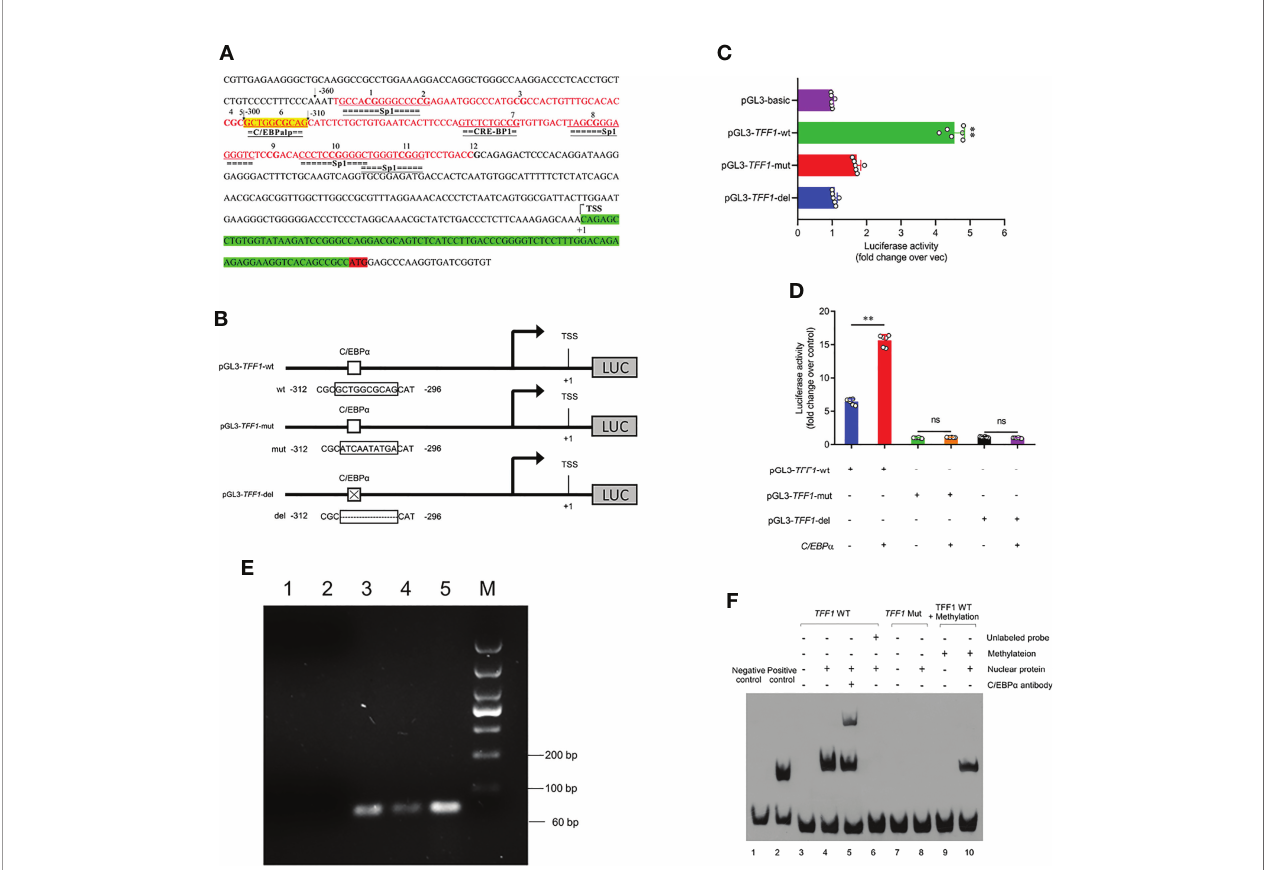
FIGURE 5 | C/EBP a activates the TFF1 expression. (A) Schematic representation of the TFF1 promoter sequences. C/EBP a potential binding site is highlighted in yellow. CpG island is highlighted in red and CG sites are shown in bold font. TSS was the transcription start site, and de fi ned as +1. (B, D) The pGL3- TFF1 recombinant vectors (with or without C/EBP a consensus site) were constructed and co-transfected with C/EBP a -oe into IPEC-J2. (C) The pGL3- TFF1 constructs (pGL3- TFF1 -wt, pGL3- TFF1 -mut and pGL3- TFF1 -del) were transfected into IPEC-J2. Luciferase reporter assays were performed 36 hours post transfection. (E) Identi fi cation of C/EBP a binding to TFF1 promoter by ChIP-PCR. Lane 1, PCR ampli fi cation with RNase-free H 2 O (blank control); Lane 2, PCR ampli fi cation with Rabbit IgG antibody (negative control); Lane 3, PCR ampli fi cation with anti-C/EBP a antibody; Lane 4, PCR ampli fi cation with RNA Polymerase II antibody (positive control); Lane 5, PCR ampli fi cation with Input DNA; Lane M, DL1000 DNA marker. (F) EMSAs con fi rmed the binding of the C/EBP a protein to the TFF1 promoter region. All free biotin-labeled probes ( TFF1 WT probes, Lane3-6, and Lane9-10; TFF1 Mut probes, Lane7-8) were examined by streptavidin-HRP conjugate. Lane 5, Super-shift mobility band was con fi rmed complex of biotin-labeled TFF1 WT probes and C/EBP a protein. Lane 6, unlabeled probes was a cold competitor probe. Lane 9-10, TFF1 WT probes were treated by methyl transferase M.Sss I. Data are presented as mean values ± SD, using two tailed Student's t-test analysis. **P < 0.01, ns, not signi fi cant. Each treatment has triplicate biological replicates at